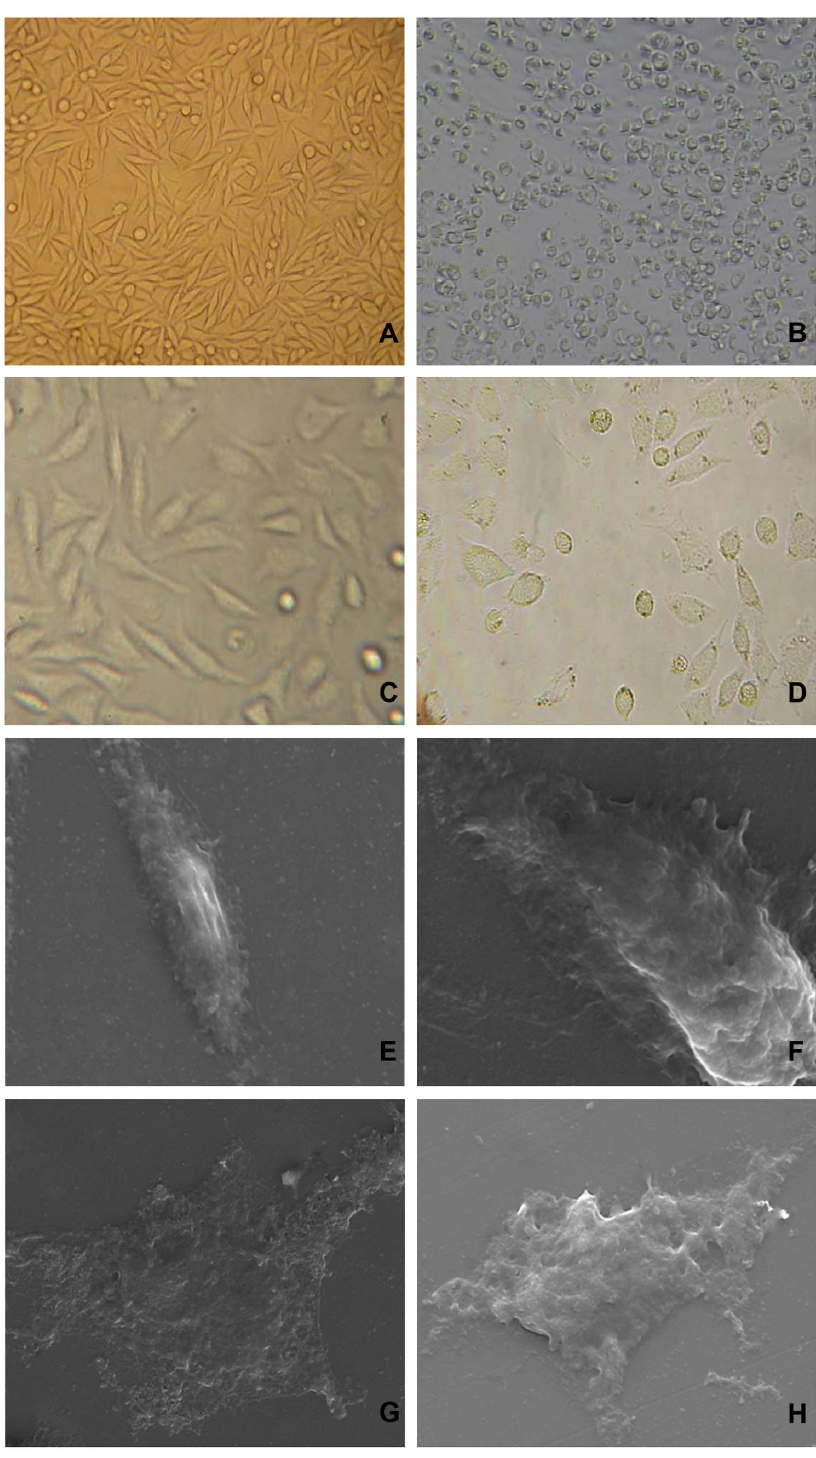
Figure 4. Morphologies of the cultured L929 mouse fibroblasts for 3 and 5 days. Morphologies with the light microscopy of the cultured L929 mouse fibroblasts for 3 days and extracts test. (A) negative control ( 6 100): Fibroblasts were polygonal and cell division could be observed; (B) positive control ( 6 200): Dying and dead fibroblasts were significantly smaller and floating. (C) nano-Cu/LDPE IUD-50% extracts ( 6 400): Fibroblasts were polygonal and cell division could be observed. A very small amount of cells were round; (D) TCu220C IUD-50% extracts ( 6 400): An amount of fibroblasts were dying and dead. Morphologies with scanning electron microscopy of the L929 mouse fibroblasts cultured with 50% extracts for 5 days. (E) nano-Cu/LDPE IUD-50% extracts ( 6 3000): Fibroblasts membrane was integral; (F) nano-Cu/LDPE IUD-50% extracts ( 6 6000): Membrane surface and the edge had long microvillus. (G) TCu220C IUD-50% extracts ( 6 3000): Cells disintegrated and became larger. The cytoplasm was spillover; (H) TCu220C IUD-50% extracts ( 6 4000): Fibroblasts were partial rupture.